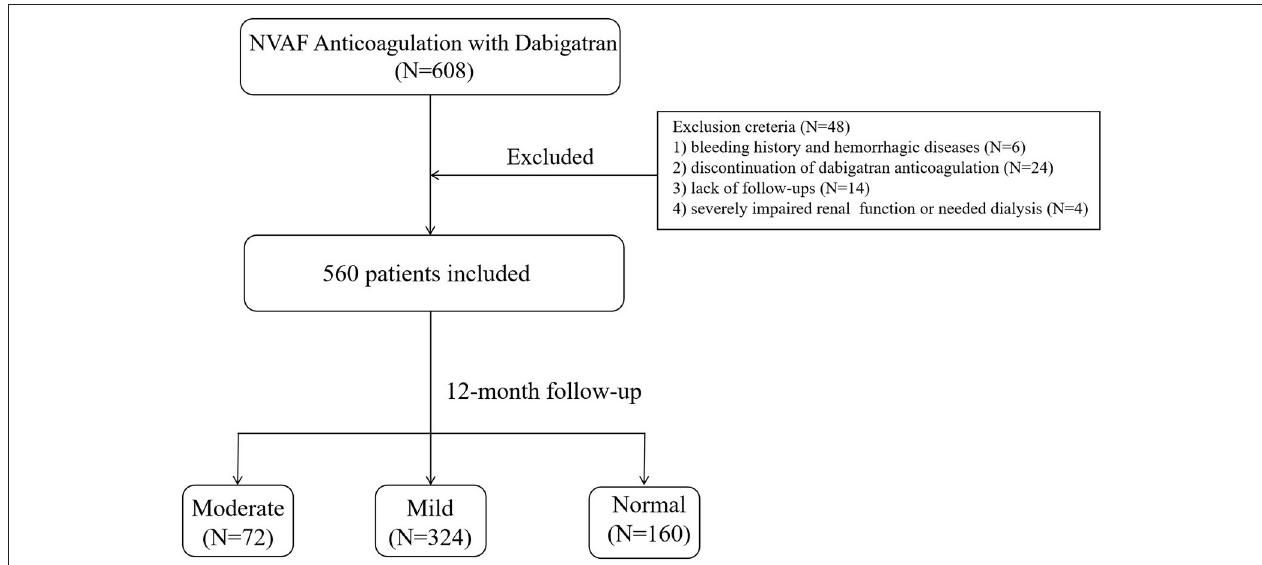
FIGURE 1 | Diagrammatic presentation of our